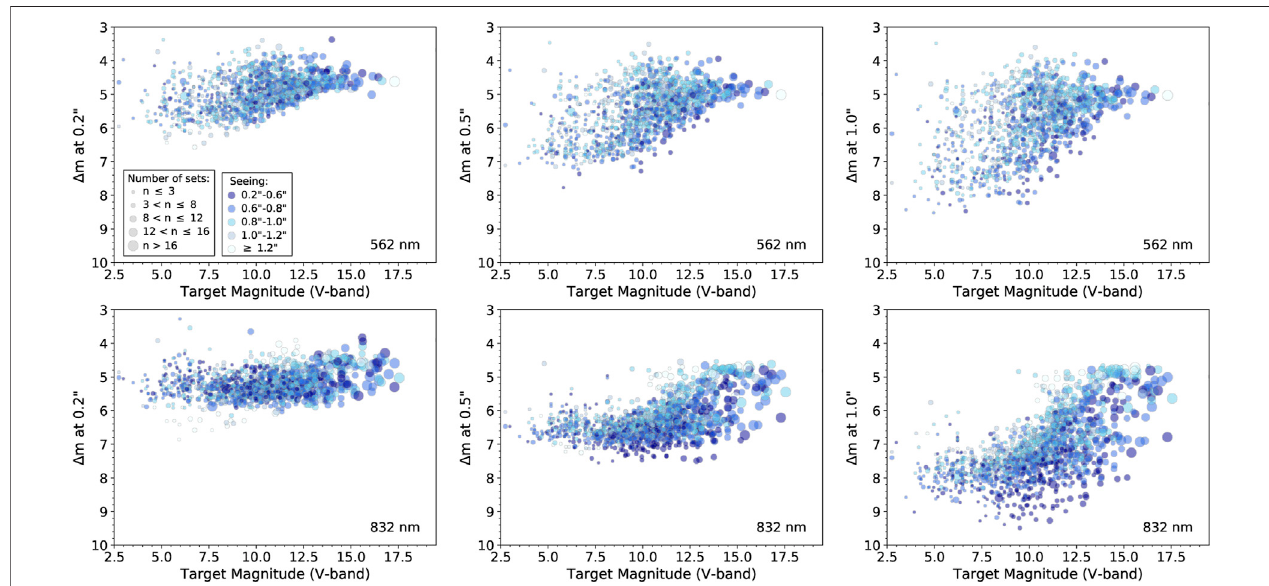
FIGURE 9 | Similar to Figure 8 , but for the Zorro observations from the 2019A to the 2021B semester.